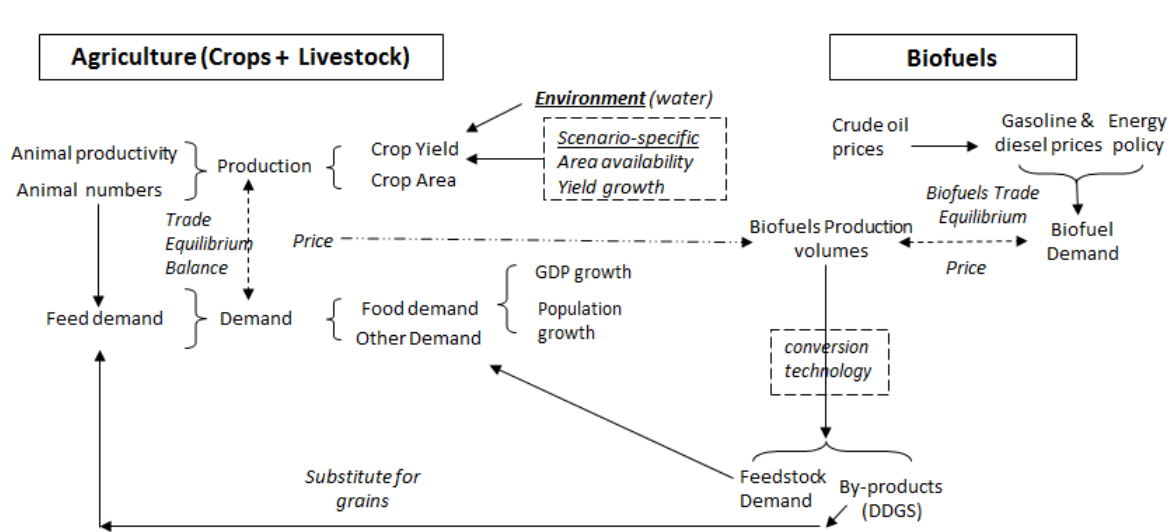
Figure 3. Schematic of quantitative modeling